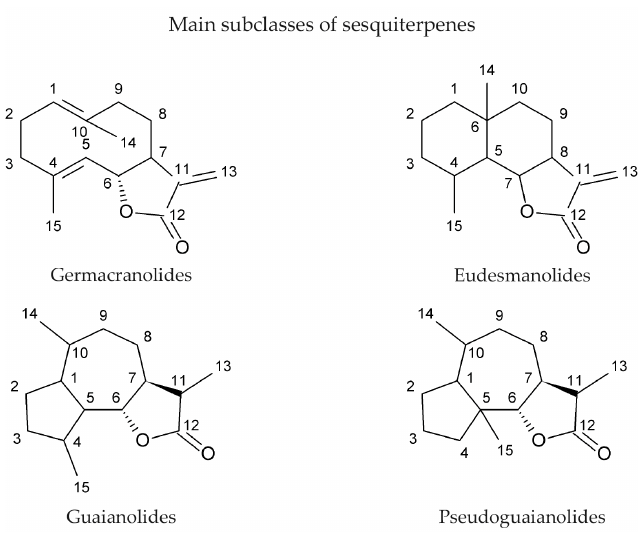
Figure 1. The chemical structures representing the main subclasses of sesquiterpenes are shown. The positions of carbons are numbered.